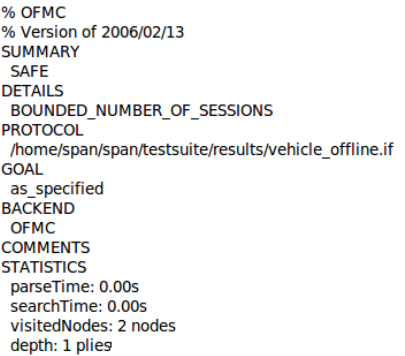
Figure 21. Results of the offline phase with OFMC backend.